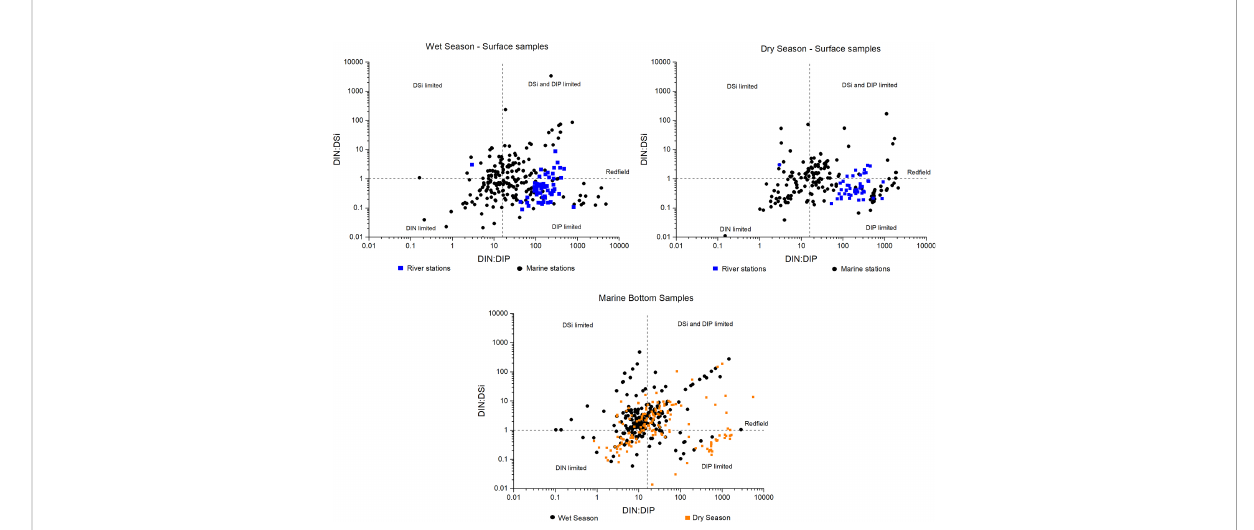
FIGURE 3 Inorganic macronutrients relationship between DIN, DIP and DSi during wet (high river fl ows) and dry (low river fl ows) seasons. The blue squares are all the samples from the Doce River channel along the 4 stations and the black dots and orange squares are all continental shelf surface and bottom water samples, respectively, for the 27 samplings in both environments. The upper left quadrant corresponds to DSi-limited samples, the upper-right quadrant to DSi and DIP-limited samples, the lower-left quadrant corresponds to DIN-limited samples, and the lower-right quadrant to DIP-limited